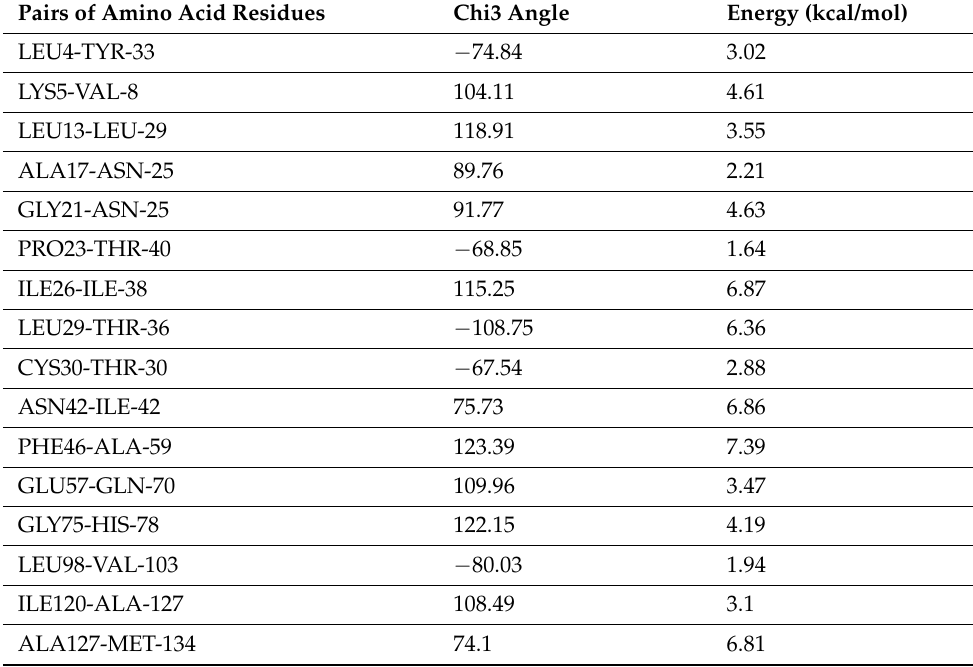
Table 3. Pairs of mutated amino acids, Chi3 values and energy